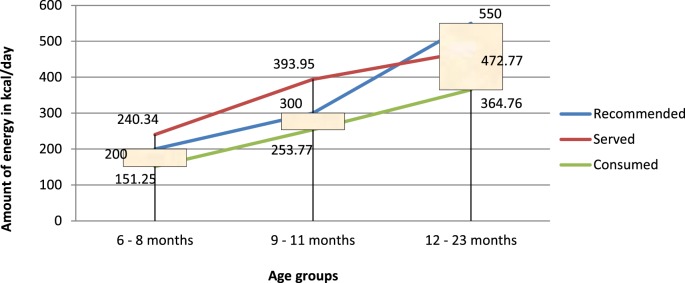
Comparison of energy served and/or consumed (in kilocalories per day) to recommended intakes.